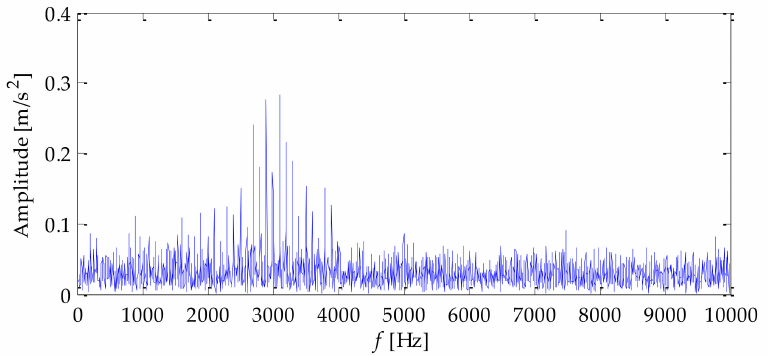
Figure 6. Frequency–domain waveform of the mixed signal.